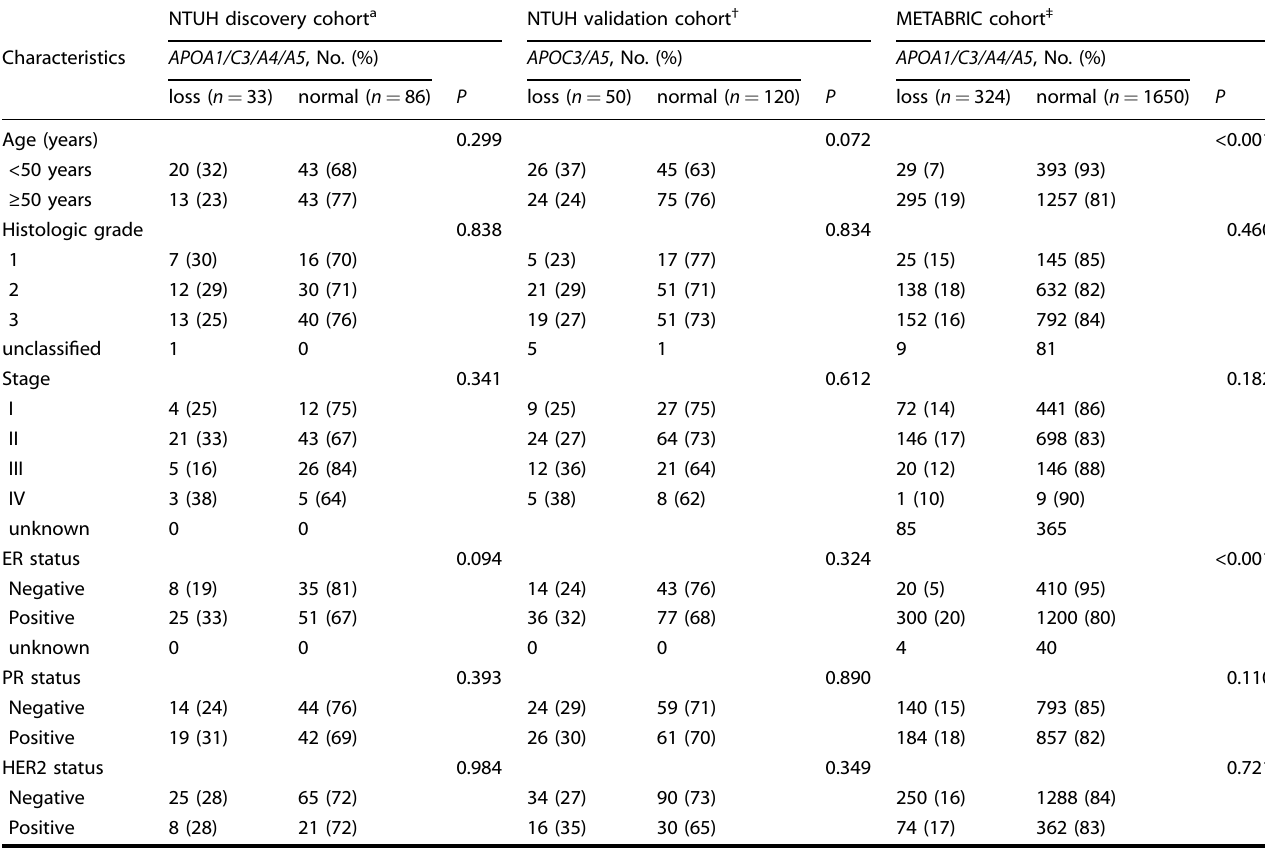
Table 2. Associations of APOA1/APOC3/APOA4/APOA5 or APOC3/APOA5 copy number loss with clinicopathological features. NTUH discovery cohort a NTUH validation cohort † METABRIC cohort